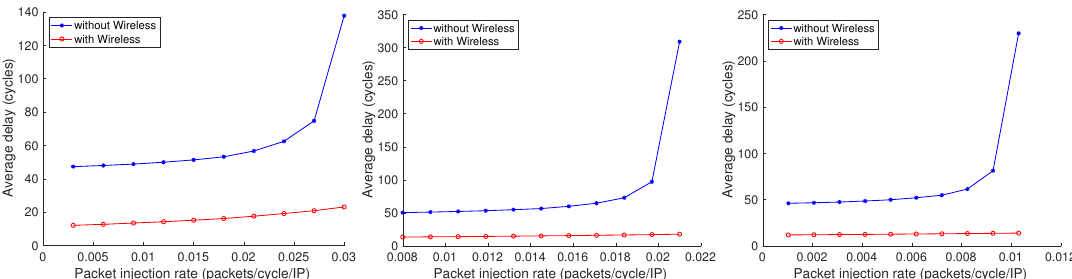
Figure 12. Average delay for profiles T 4 , T 8 , and T 16 for 256 Mesh topology and table-based traffic (TT-256